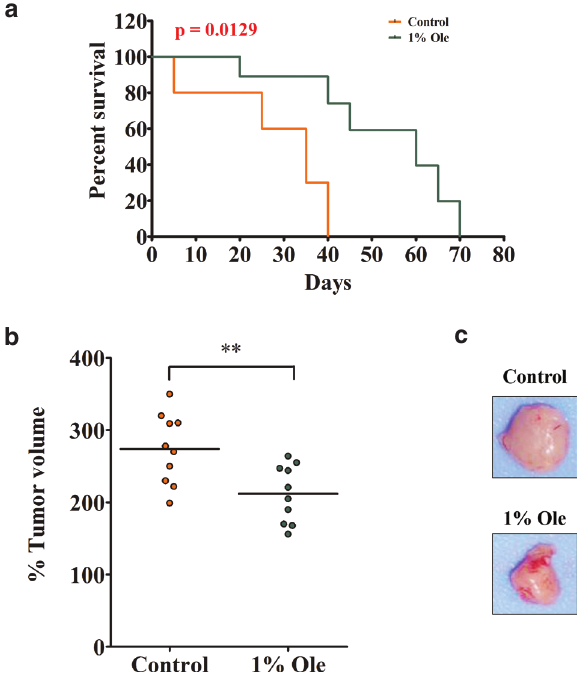
Fig. 2. Ole inhibits pancreatic cancer in vivo. (a) Survival study of KPC mice administrated with or without 1% Ole in drinking water. KPC mice were enrolled onto studies when the tumor size was reaching 200 ± 50 mm 3 as measured by 3D ultrasonography. They were randomly assigned to con- trol or treatment group, with 10 subjects in each group. The tumor size and mortality endpoint were accessed every 3 days throughout the study. (b) The tumor sizes of KPC mice in day 10 were compared between control and treatment group as determined by 3D ultrasonography. (c) The representative images of tumor samples harvested from each experimental group (* P < 0.05, ** P < 0.01, and *** P < 0.001 as compared with